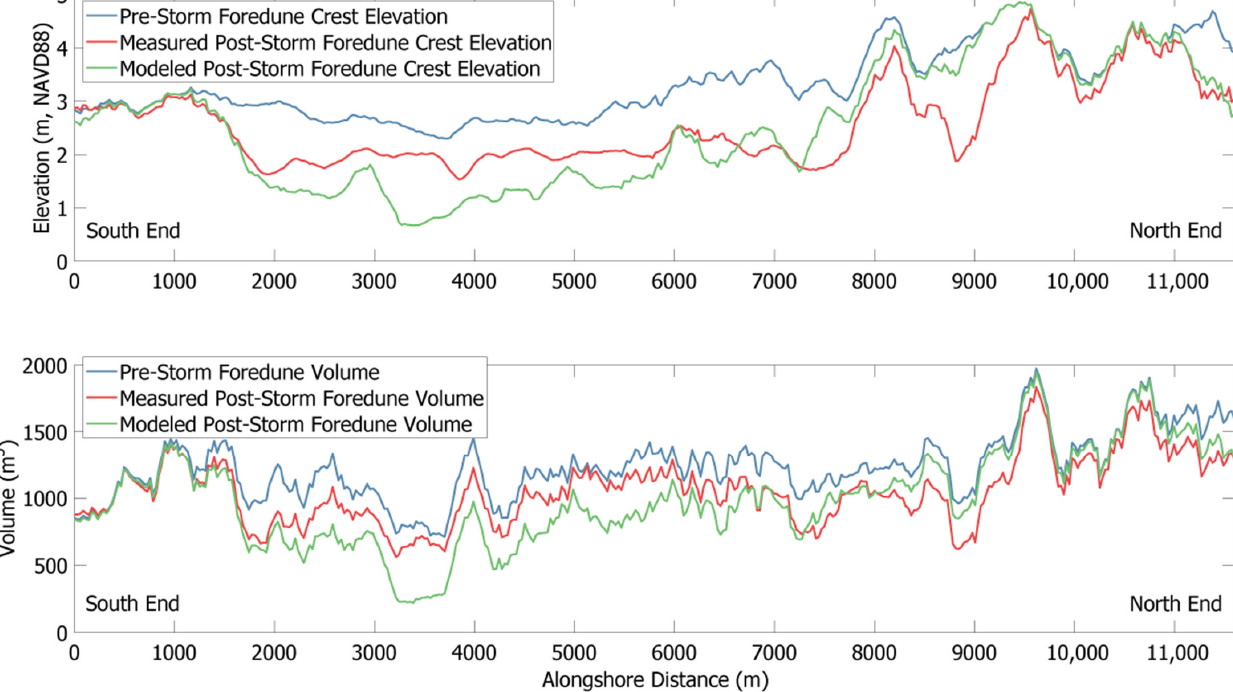
Figure 8. Comparison between measured and modeled (baseline simulation) changes to the foredune crest ( top ) and foredune volume ( bottom ).